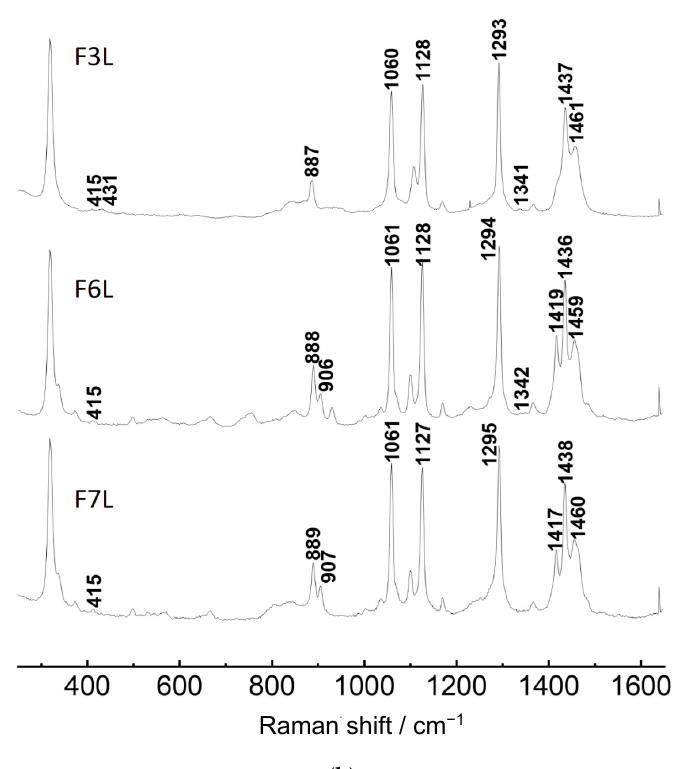
Figure 5. Raman spectra of ( a ) API or excipients and ( b ) SLM formulations over the range 200 cm − 1 –1600 cm − 1 .